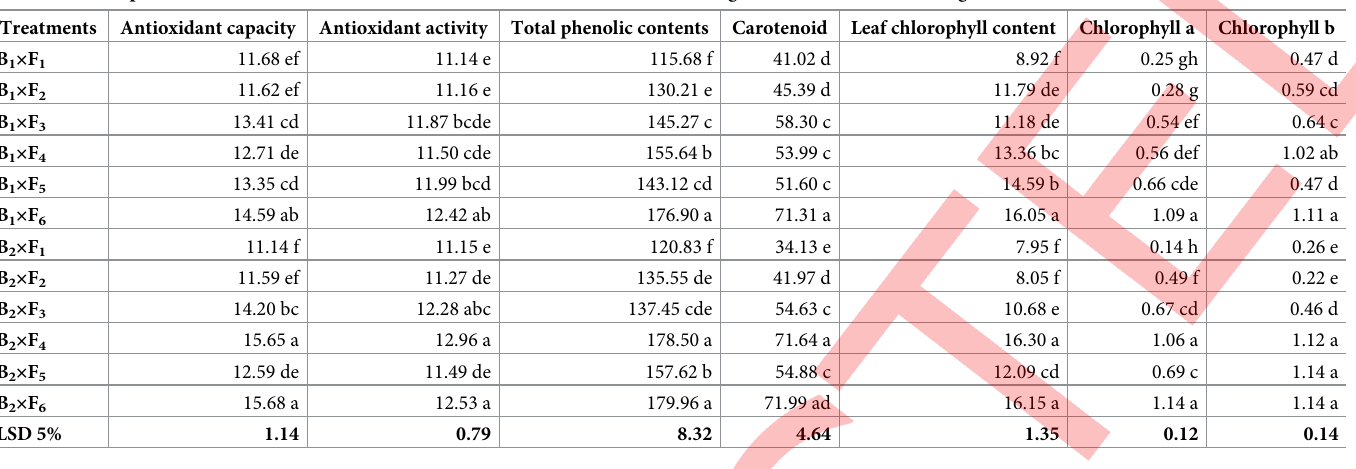
Here, B 1 = no bacteria inoculation, B 2 = bacteria inoculation, F 1 = 50% N, F 2 = 60% N, F 3 = 70% N, F 4 = 75% N, F 5 = 80% N, F 6 = 100% N, Means followed by different letters within a column statistically differ from each other (p >